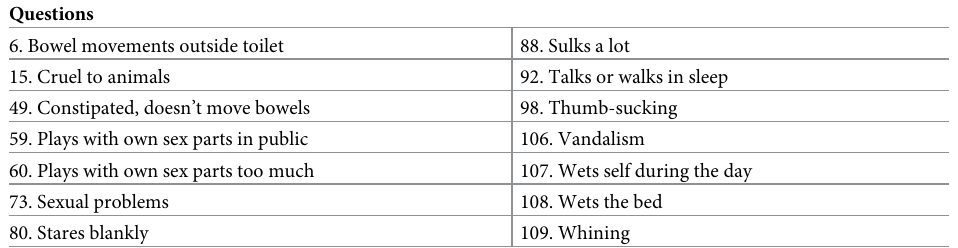
or item easiness (a tendency of i < ^ b CBCL YSR